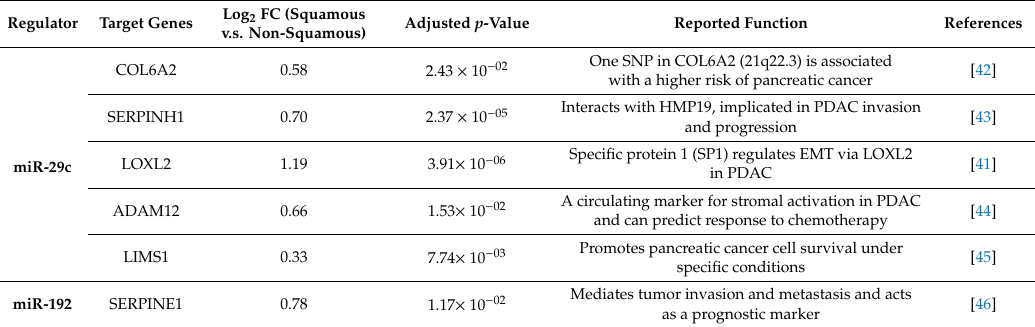
Table 2. Target genes directly regulated by master regulatory miRNAs with reported functions in PDAC. Regulator Target